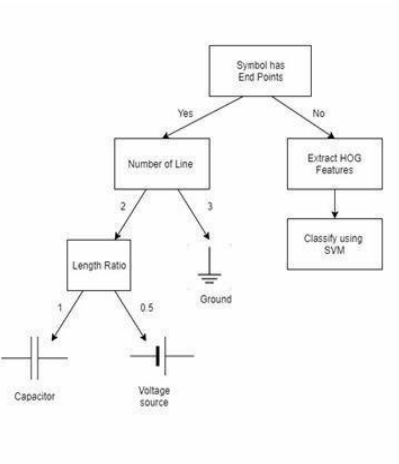
Fig. 1: Classification Flowchart